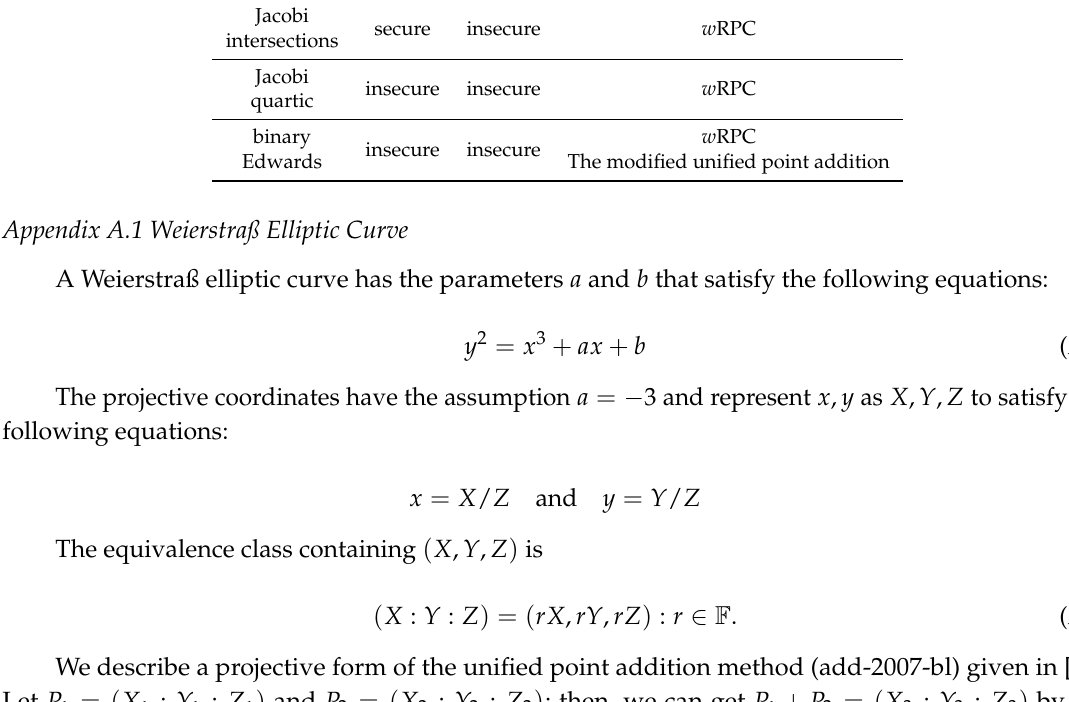
Table A1. The vulnerabilities of the elliptic curve forms and it countermeasures. Curve Type 1 Type 2 Countermeasures w RPC Weierstraß insecure insecure The modified unified point addition Hessian insecure w